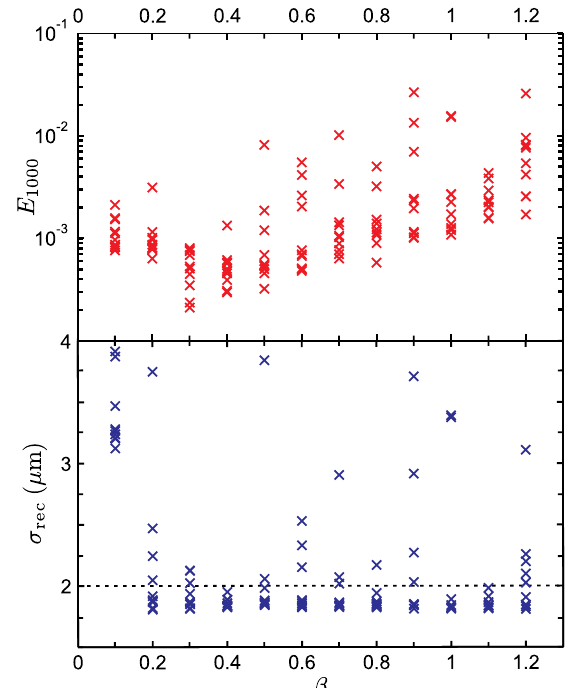
FIG. 2. Performance of the hybrid input-output algorithm for different values of the parameter (cid:3) , when reconstructing the spectrum of a Gaussian of 2 (cid:6) m rms length on a fixed support of length 15 (cid:6) m . The rms length of the reconstructed profiles is (cid:7) rec , while E 1000 shows the reconstruction error after 1000 iterations, as defined by Eq. (4). The spectrum is truncated at wavelengths above 7 (cid:6) m , leading to consistent underestimates . Each reconstruction run consists of 990 iterations of the of (cid:7) z HIO algorithm followed by ten iterations of the Gerchberg- Saxton algorithm. Ten reconstructions were carried out for each value of (cid:3)